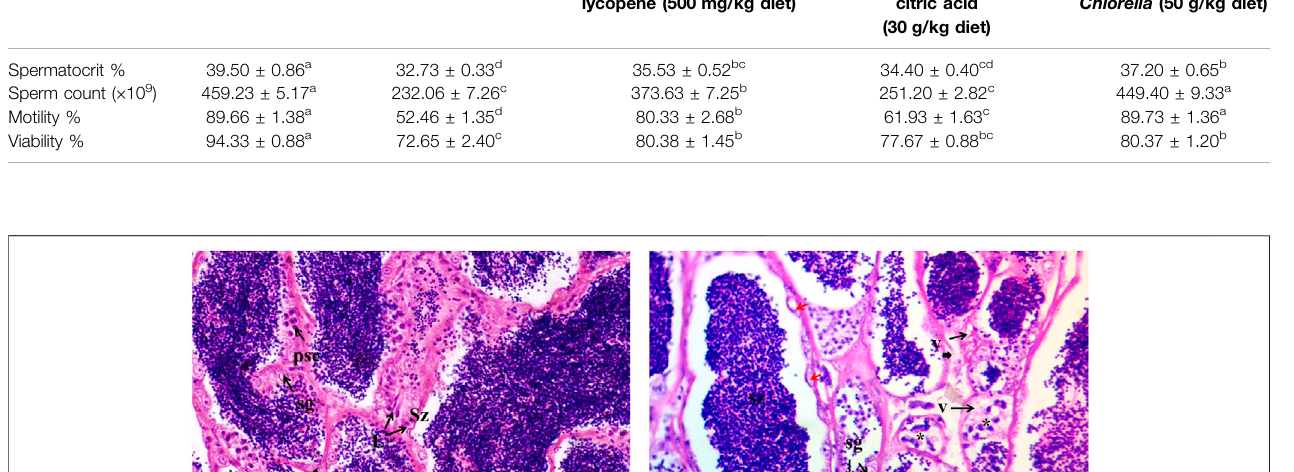
Frontiers in Environmental Science |